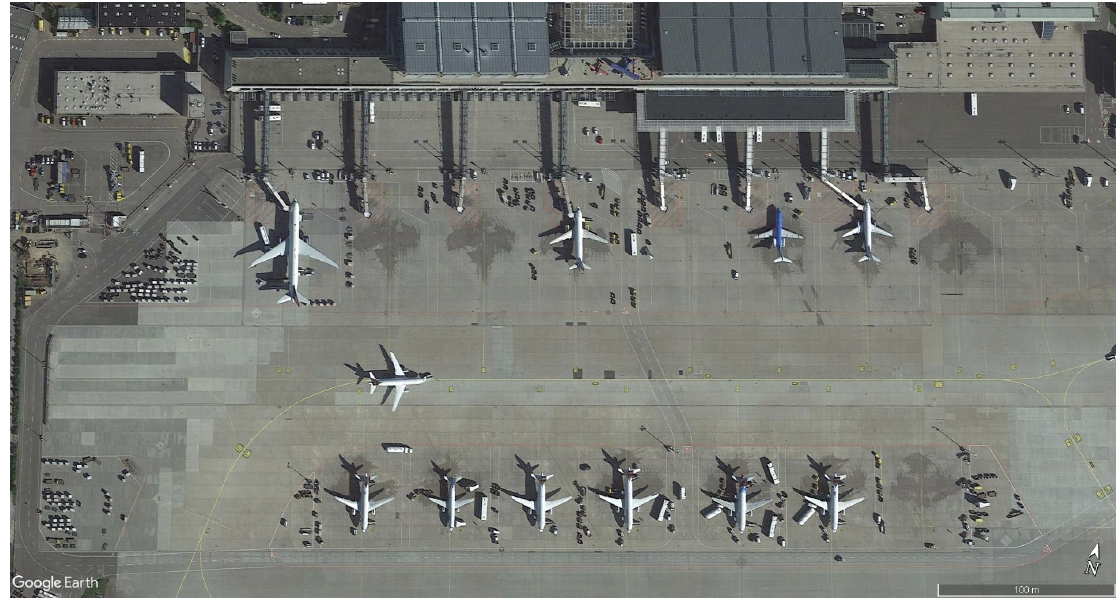
Figure 1. Selected part of the apron at Stuttgart Airport (Source: Google Earth (Landsat/Copernicus, V 7.3.0.3832, Google Inc., Mountain View, CA, USA) on 24 April